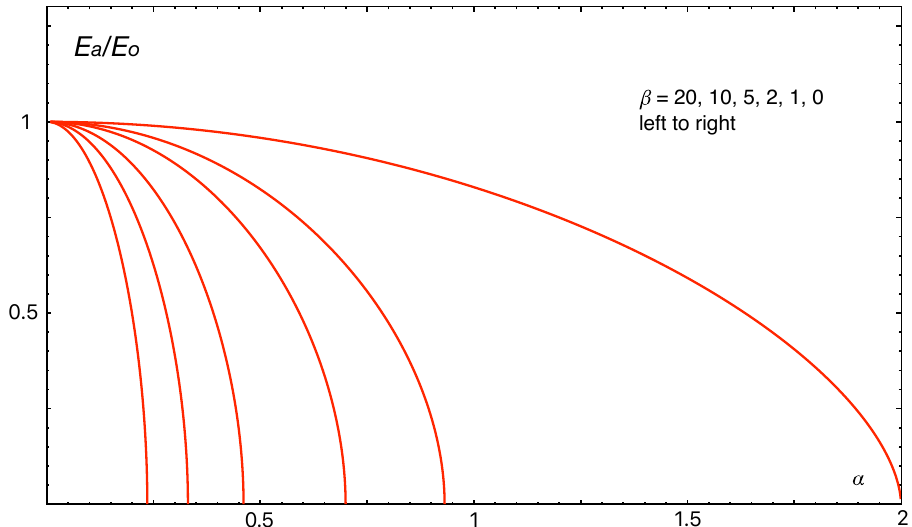
Figure 8. Behavior of E a / E ◦ vs. α , for different values of the feedback parameter β . Reproduced from reference